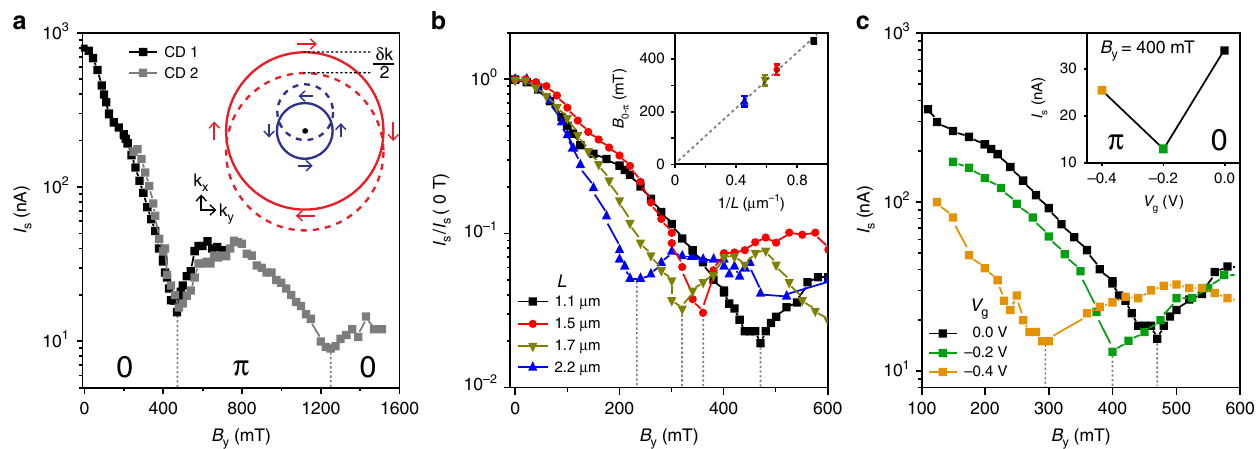
Fig. 2 Magnetic fi eld-driven 0 − π transitions. a Variation of the switching current, I s , with in-plane magnetic fi eld, B y , at V g = 0 V for the same JJ as in Fig. 1b, c. Two distinct revivals of I s are visible at B y = 470 mT and 1250 mT, associated with 0 − π transitions. The data are from two cool downs (CDs). The momentum shift, δ k /2, of the Fermi surfaces due to the Zeeman fi eld is sketched in the inset. The solid (dashed) lines depict the situation at zero ( fi nite) magnetic fi eld, and the arrows represent the spin orientation. b I s as a function of B y at V g = 0 V for four JJs with different lengths. For better visibility, I s is normalized with respect to I s at B y = 0 T. Dashed lines indicate B 0- π , the fi eld at which the transition occcurs for each length. The inset shows a linear dependence of B 0- π on 1/ L , in agreement with ballistic transport. c I s vs. B y at three different V g for the JJ with L = 1.1 μ m. B 0- π shifts to lower values of B y with more negative gate voltages. I s vs. V g at B y = 400 mT shows a non-monotonic behavior as displayed in the inset. The length and gate dependence of panel b , c are in qualitative agreement with Eq. 0 – π transitions in Josephson junctions . Using these ballistic